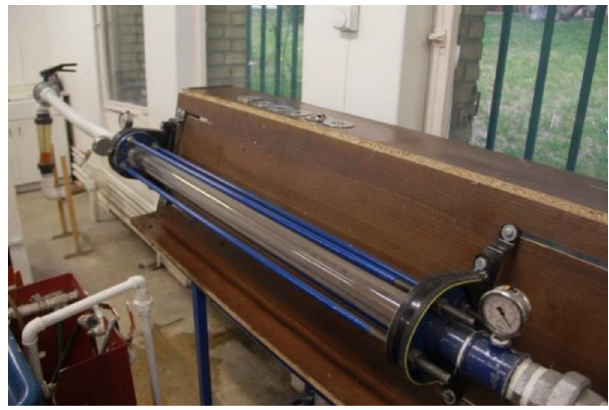
Fig. 1. The experimental setup of cavitation in the ori